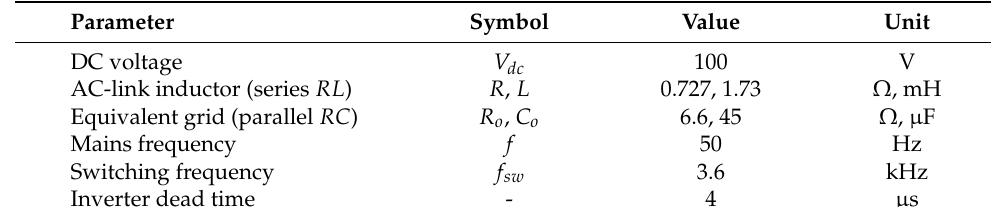
Table 3. Experimental setup’s main system parameters.